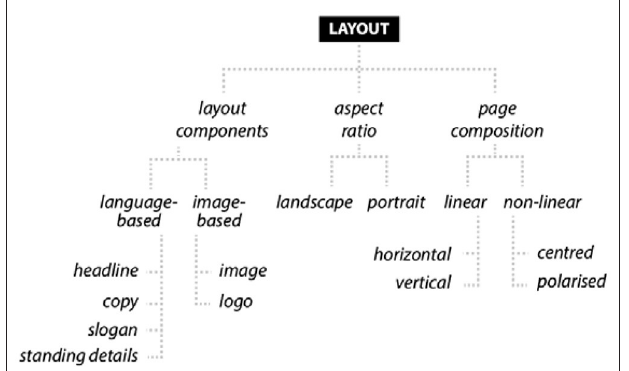
FIGURE 1 | Taxonomic overview of concepts for an analysis of layout in print ads.